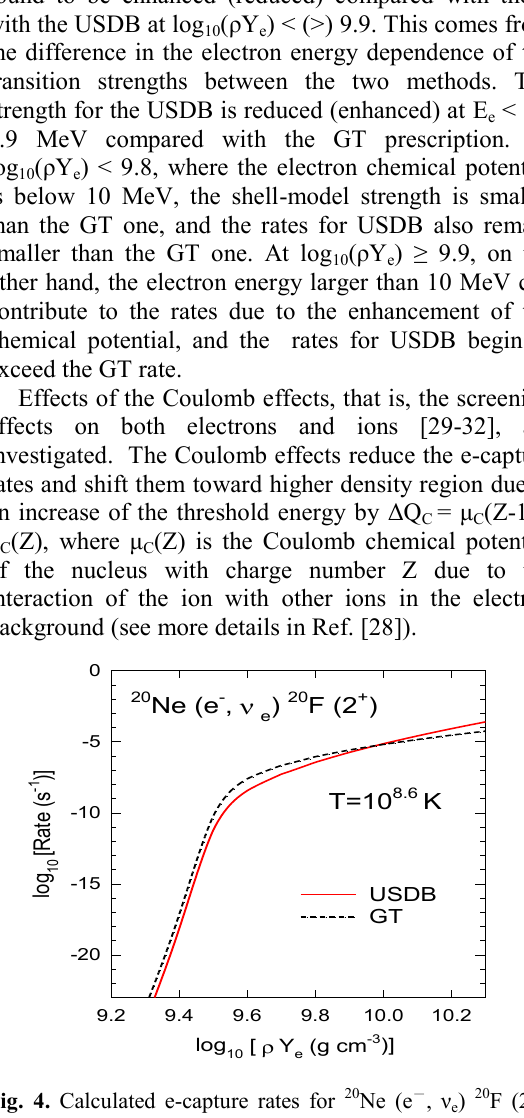
Fig. 4. Calculated e-capture rates for 20 Ne (e － , ν e ) 20 F (2 1+ ) obtained by shell-model calculations with the USDB at log 10 T =8.6. Results obtained by the prescription assuming an allowed GT transition are also